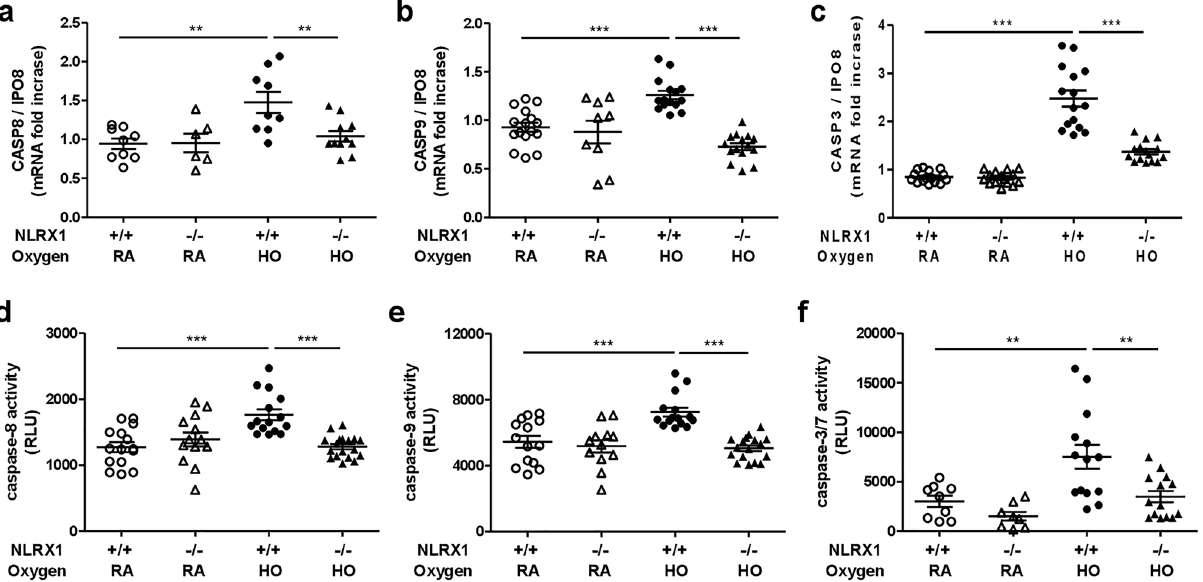
Figure 4. NLRX1 deficiency reduces the expression of caspase and caspase activity in hyperoxic acute lung injury. ( A – C ) The mRNA levels of Caspase (CASP) -8, -9, and -3 were evaluated by real-time PCR. ( D – F